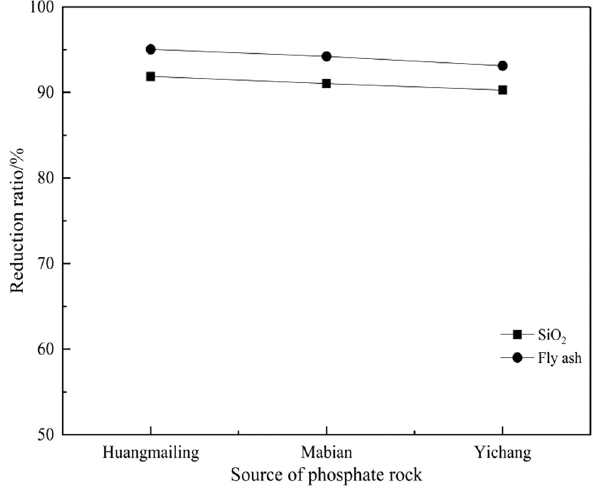
Figure 4: Reduction rate of di ff erent phosphate rock under opti - mized